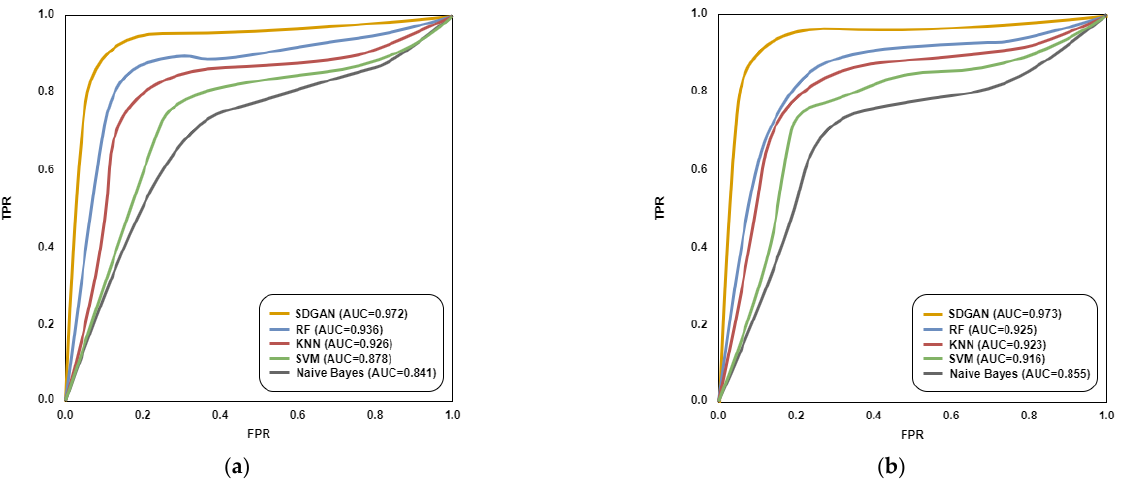
Figure 6. ROC curves of ML-based defense DDoS detection and SDGAN on conventional DDoS attack: ( a ) NSL-KDD; ( b ) CIC-IDS2018.